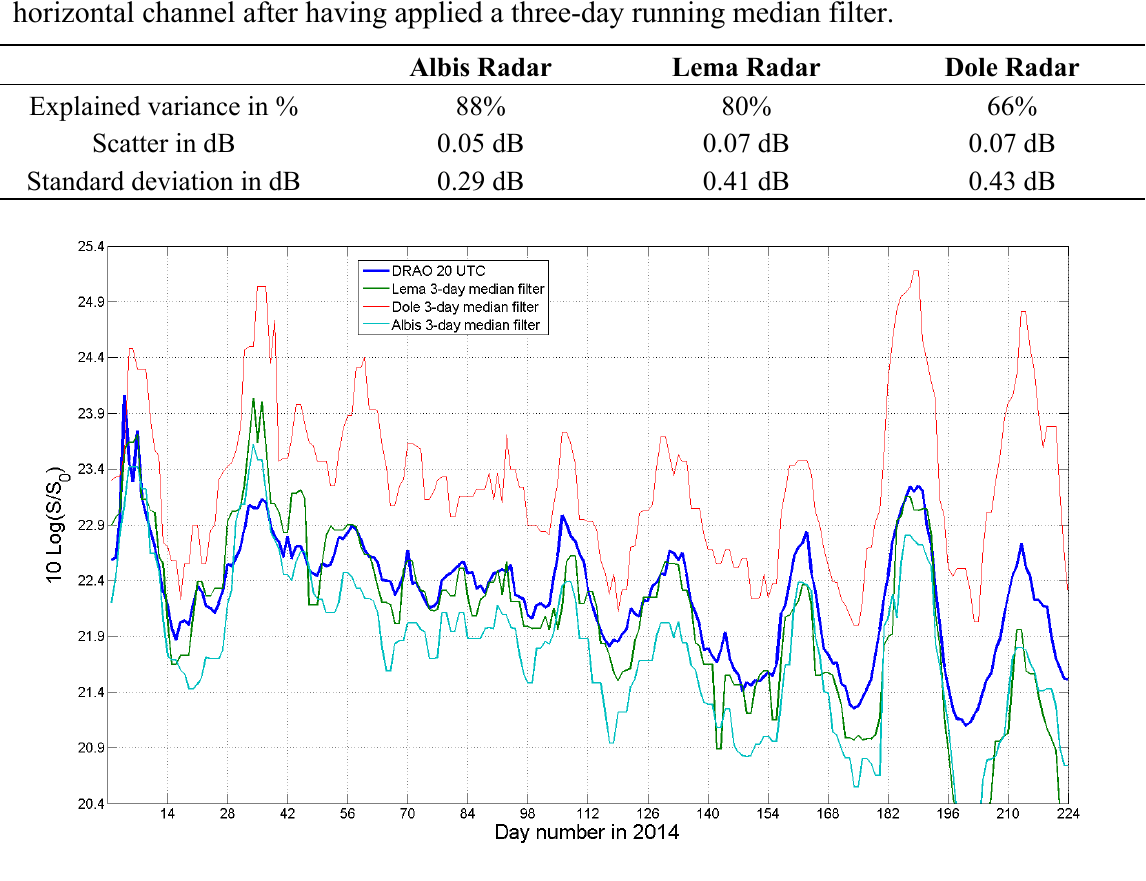
Figure 3. Daily variability of the Sun’s emission retrieved from the MeteoSwiss weather radars after having applied a three-day running median to the radar data. The reference measurements acquired by DRAO are also plotted in